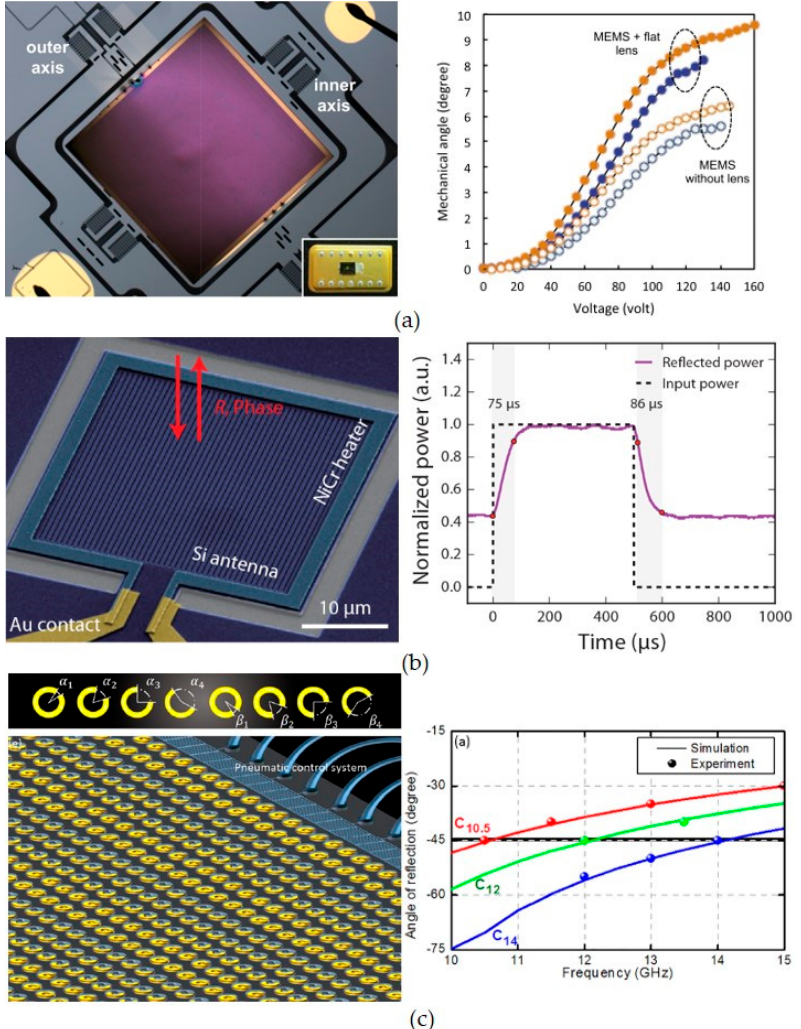
Figure 4. Dynamic beam steering based on MEMS metasurfaces and spatial light modulator (SLM). ( a ) Beam steering driven by electrostatic force, ( b ) SLM driven by thermos-optical effect; ( c ) metasurface beam steering driven by microfluidic system. Figure 4a–c are reprinted with permission from [85] copyright by AIP Publishing, 2018, [86] copyright by ACS Publishing, 2018, and [87] copyright by AIP Publishing, 2017, respectively .